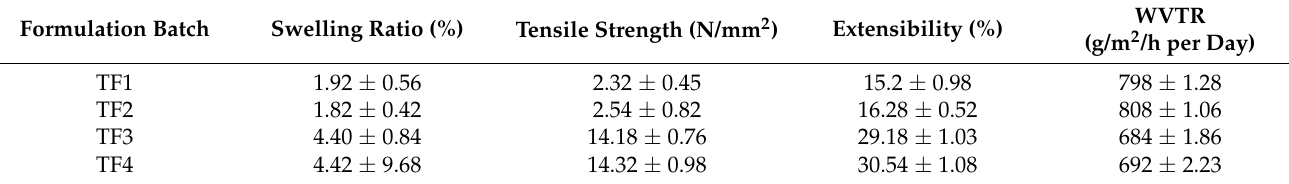
Table 4. Mechanical properties and swelling ratio of transdermal